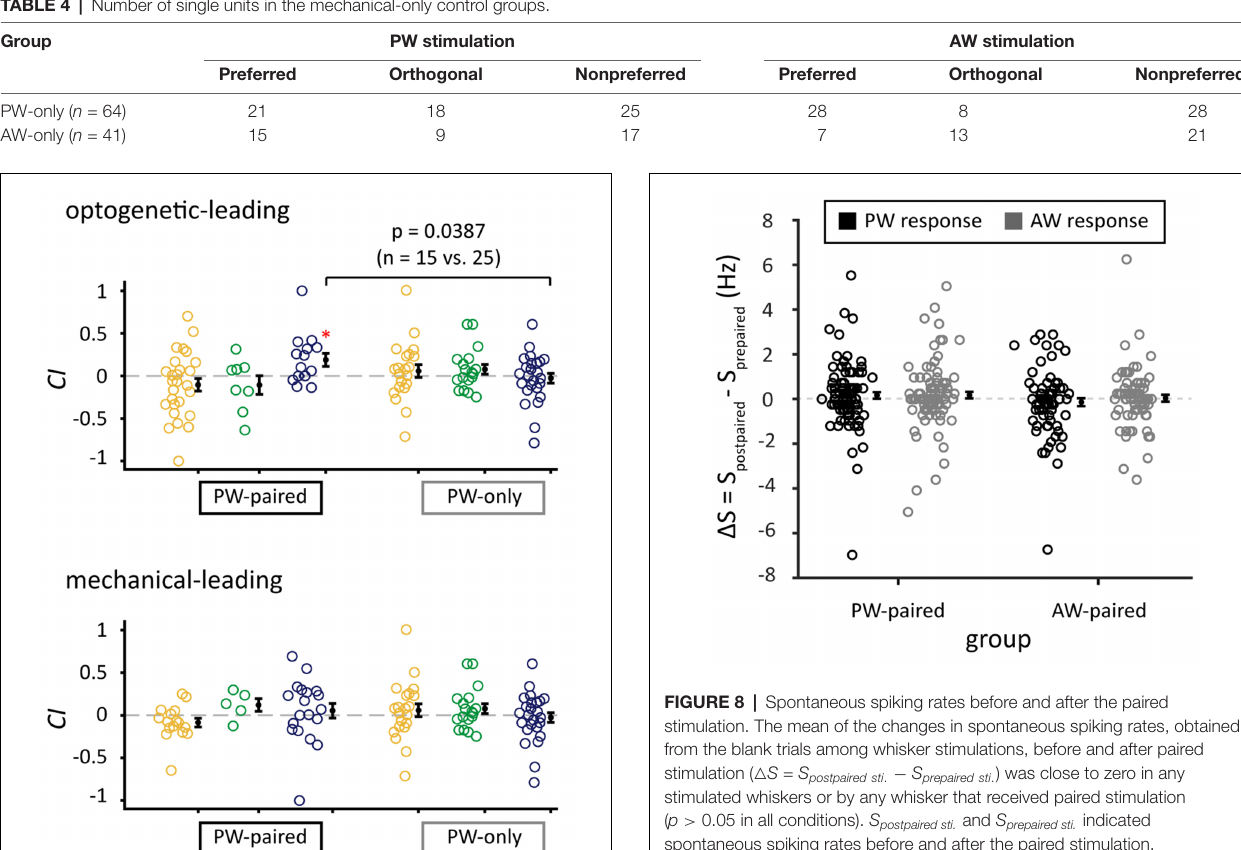
TABLE 4 | Number of single units in the mechanical-only control groups.